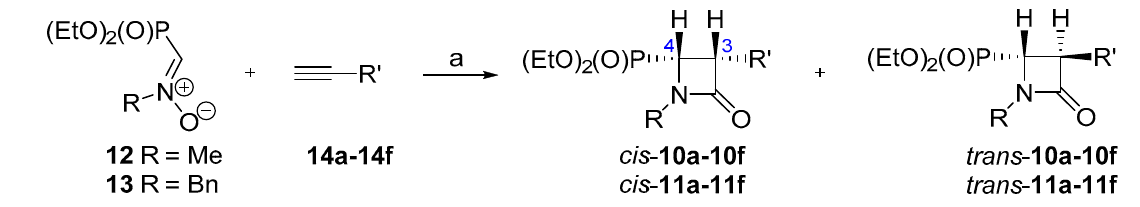
Table 1. Cycloaddtion of nitrone 12 with arylalkynes 14 .